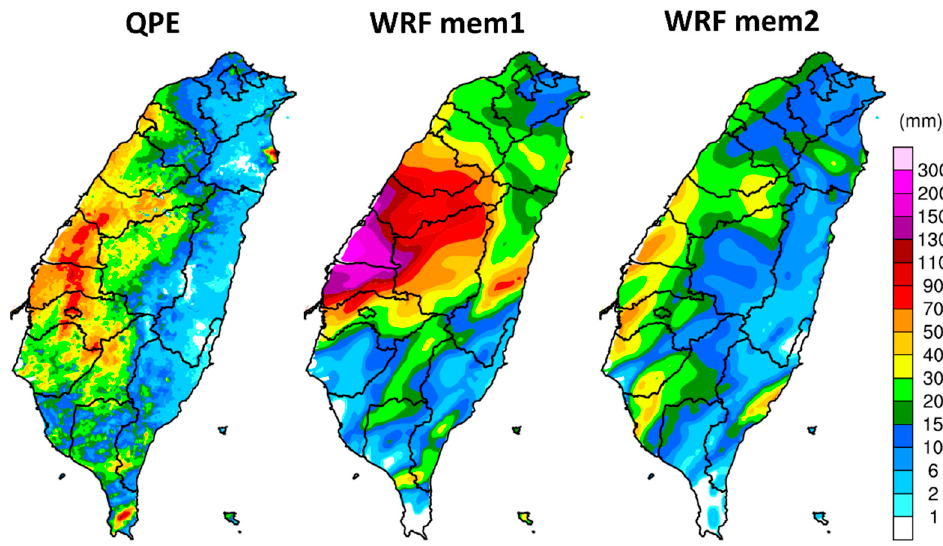
Figure 10. The maps of rainfall during 12:00 UTC 7 June–12:00 UTC 8 June 2020, for (from left to right) the radar-derived QPE data and the predicted 24–48-h rainfall of the forecasts initialized at 12:00 UTC 6 June 2020, for WRF Members 1 and 2.